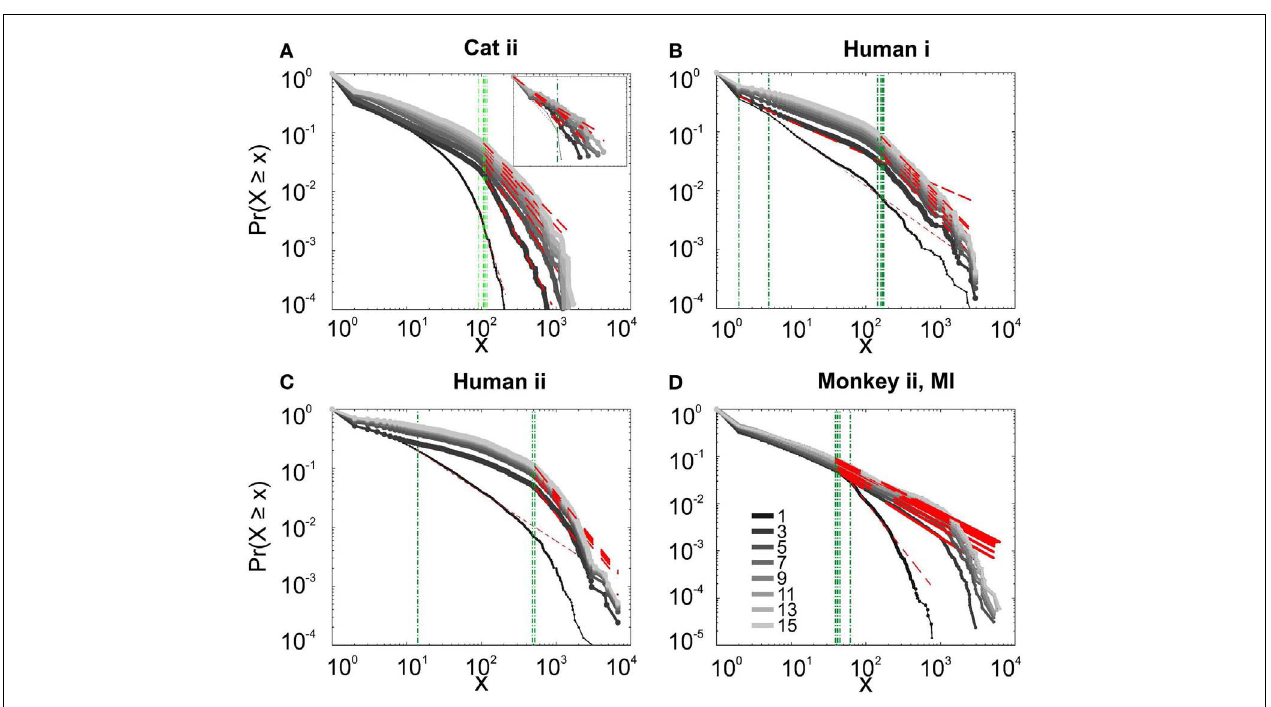
trend in CDF shows that the observed linear trend in log-log scale, as shown in Figures 7 and 8 , are not sufficient for showing that avalanche dynamics are power-law processes. For the mean/STD exponent values, see Table 3